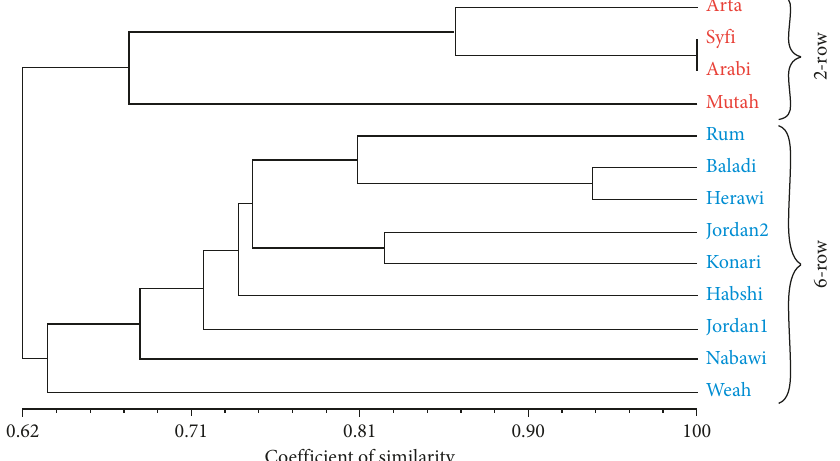
Figure 4: A dendrogram of relationships among 13 barley genotypes using DICE genetic similarity and UPGMA clustering